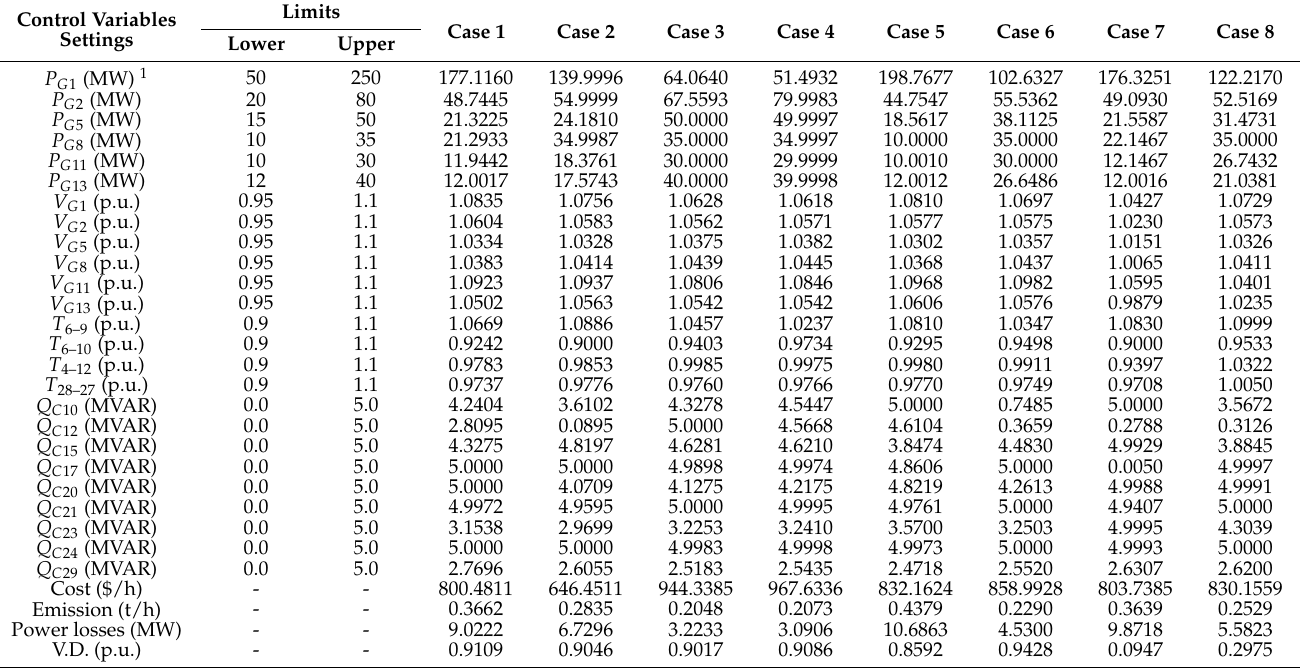
Table 1 summarizes all AGTLBO’s optimal options for the 30-bus power grid. Table 1. Optimal control variables at the lowest cost (best solution) for each test